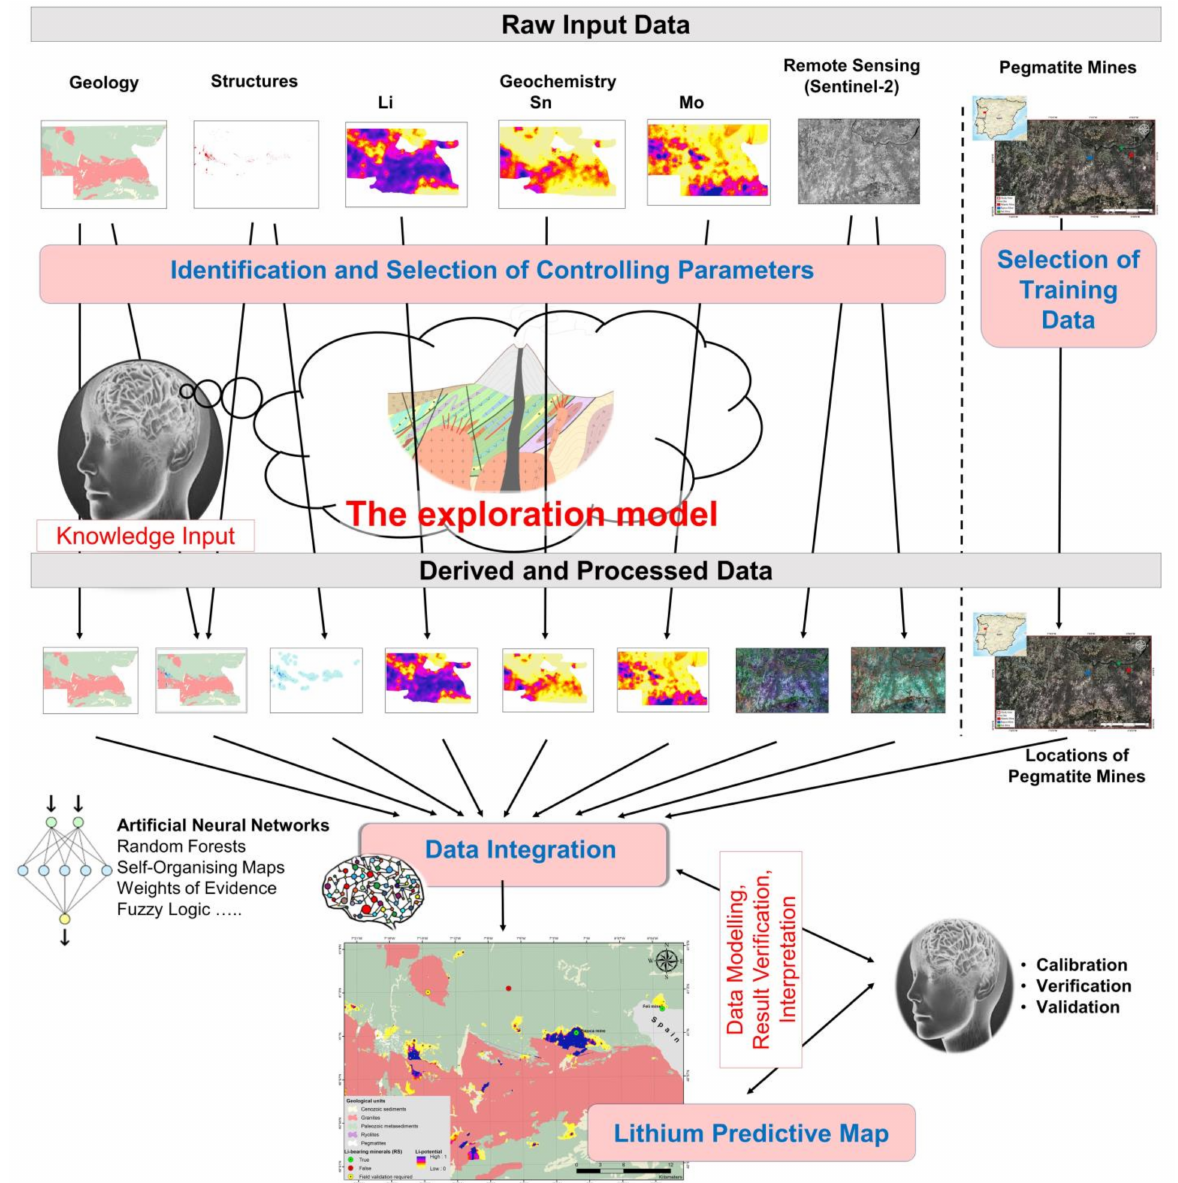
Figure 4. General processing schema in the advangeo®prediction